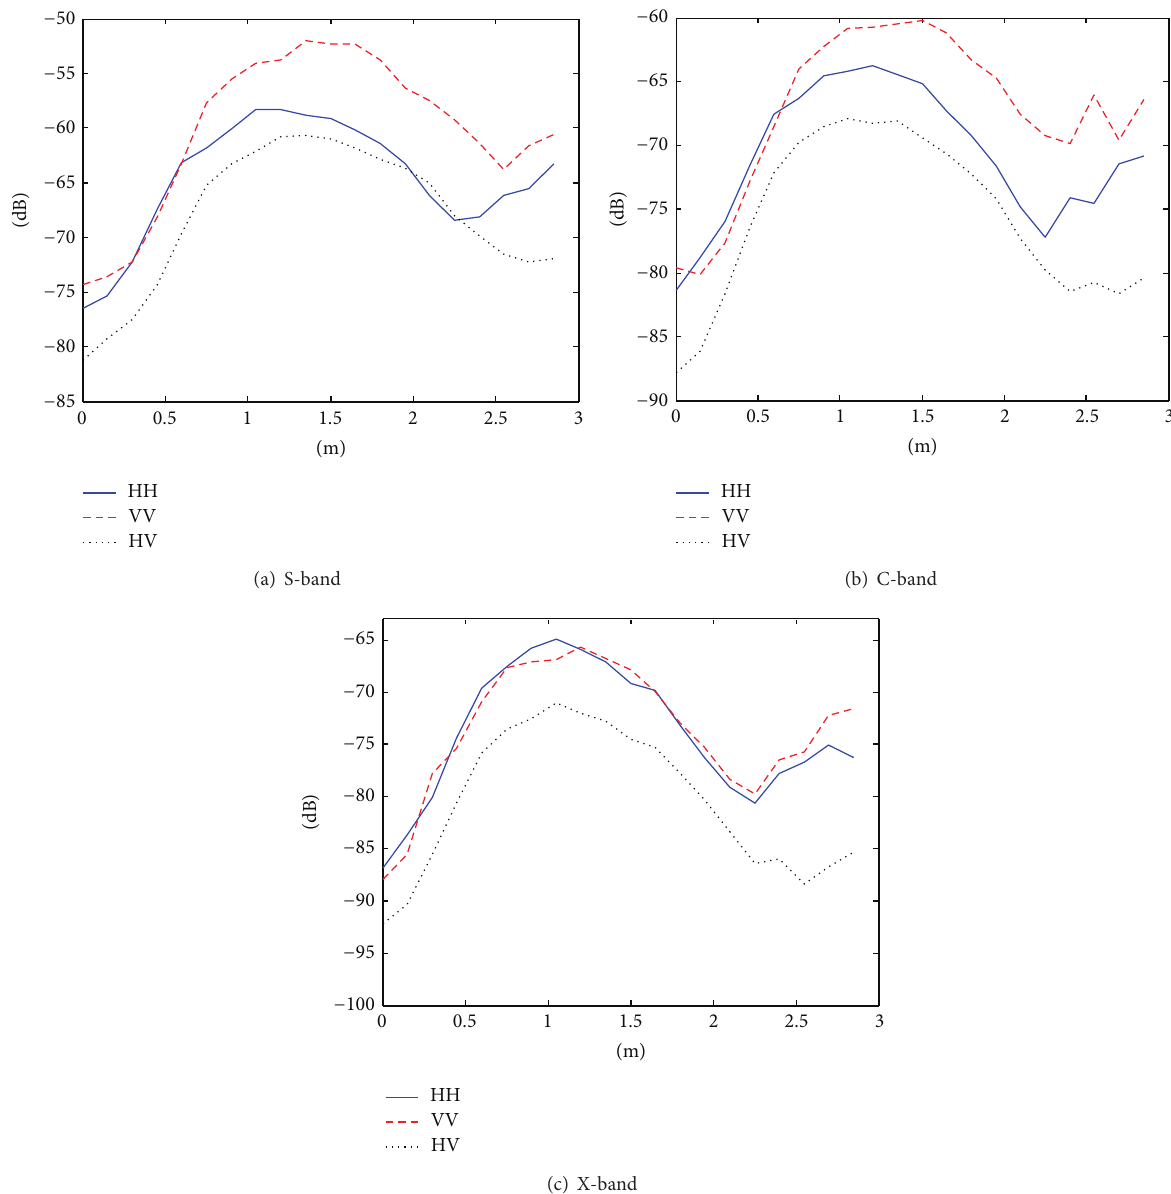
Figure 4: Backscattering power profiles for different